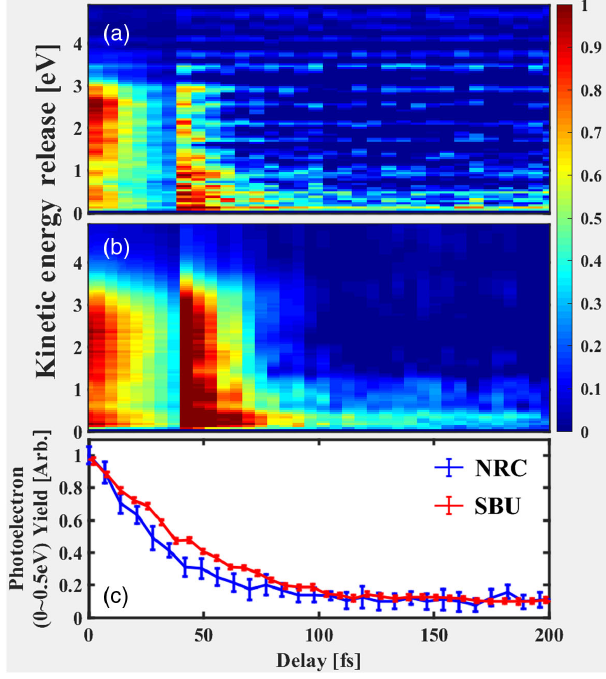
FIG. 12. Comparison of TRPES measurements carried out at two different locations with different pump-pulse parameters. (a) TRPES measurements carried out at the National Research Council in Canada (NRC) with a pump-pulse intensity of 0 . 5 TW = cm 2 and a bandwidth of 2 nm FWHM. (b) TRPES measurements carried out at Stony Brook University (SBU) with a pump-pulse intensity of 1 . 0 TW = cm 2 and a bandwidth of 1.5 nm FWHM. (c) Yield of low-energy electrons for the two measurements. In panels (a) and (b), both spectra are multiplied by a factor of 4 after 40 fs, as in Fig.